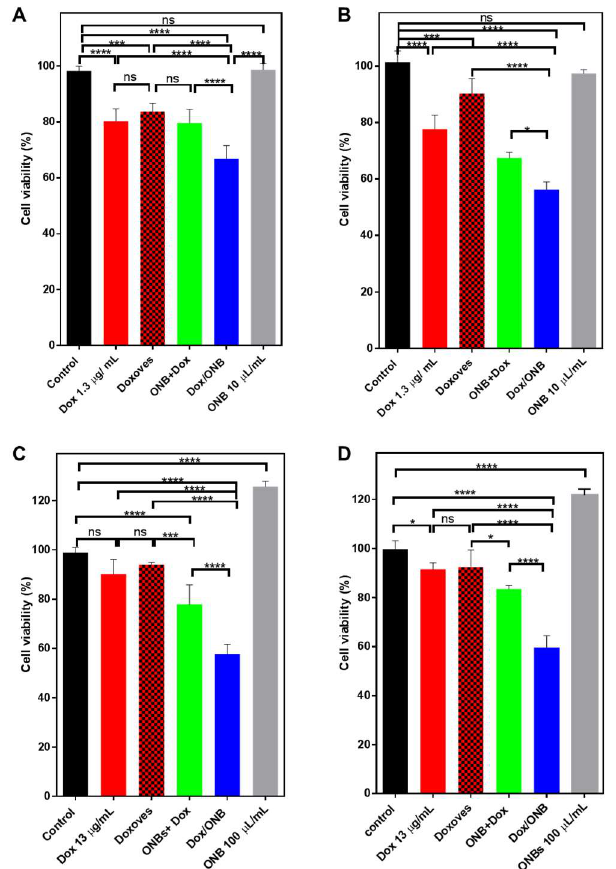
Figure 6. Cell viability and Dox efficiency measured in normal conditions and hypoxic conditions. Cell viability measured through trypan blue staining, control normalized at 100%. ( A ) Normal condition MDA-MB-231 cell line. ( B ) Normal conditions HeLa cell line ( C ) Cell viability in hypoxic conditions for MDA-MB-231 cells ( D ) Cell viability in hypoxic conditions for HeLa cells. * indicates p -value < 0.05, ** indicates p -value < 0.01, *** indicates p -value < 0.001, **** indicates p -value < 0.0001 ns indicates no significant difference. Statistical analysis was done by using one-way ANOVA followed by post hoc analysis of Tukey’s multiple comparisons test.